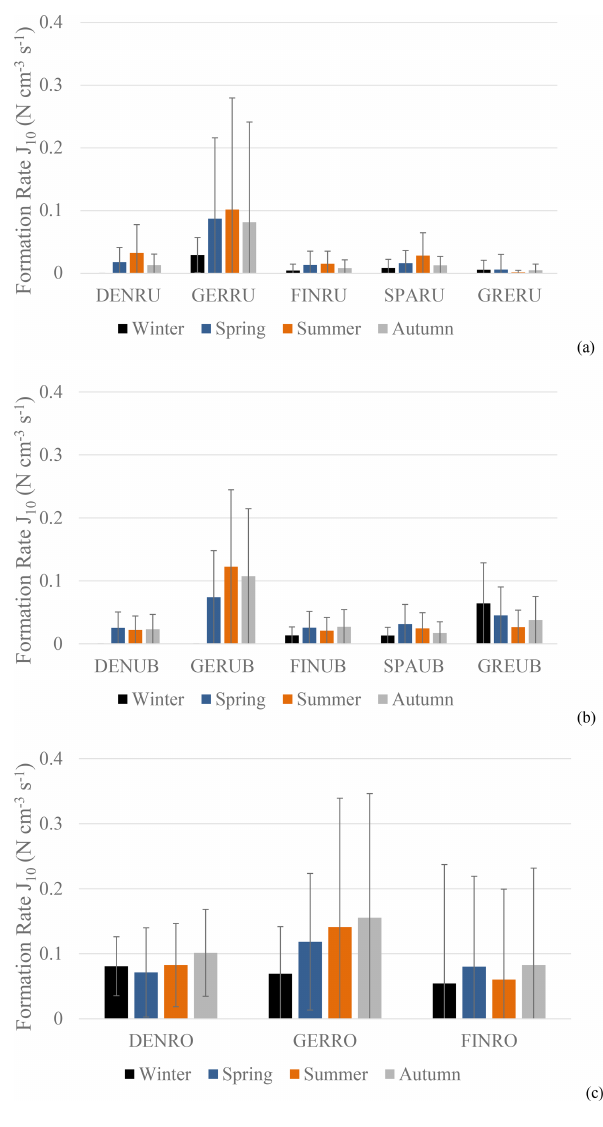
Figure 7. Seasonal variation of formation rate of 10nm particles ( J 10 ) (with standard deviations) from new particle formation events at (a) the rural background, (b) urban background, and (c) roadside